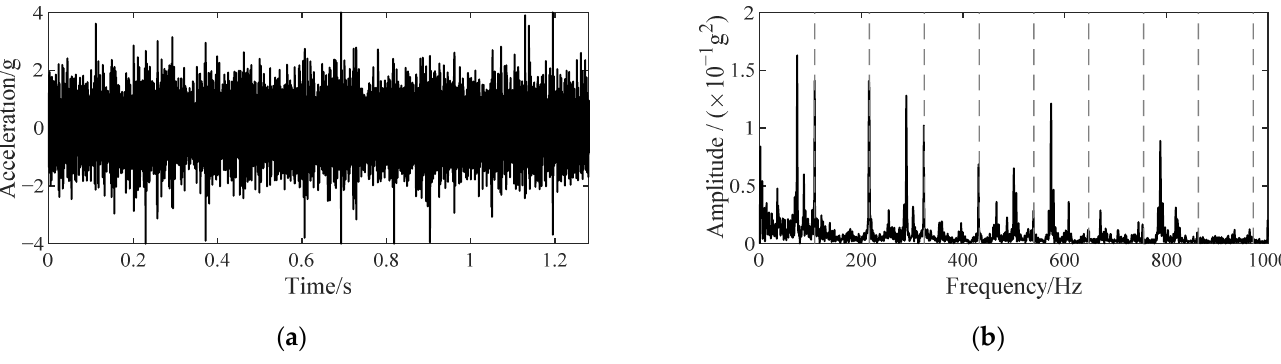
Figure A1. The signal sampled at 40th min and the spectrum obtained by improved TKEO. ( a ) The signal; ( b ) The spectrum obtained by improved TKEO.